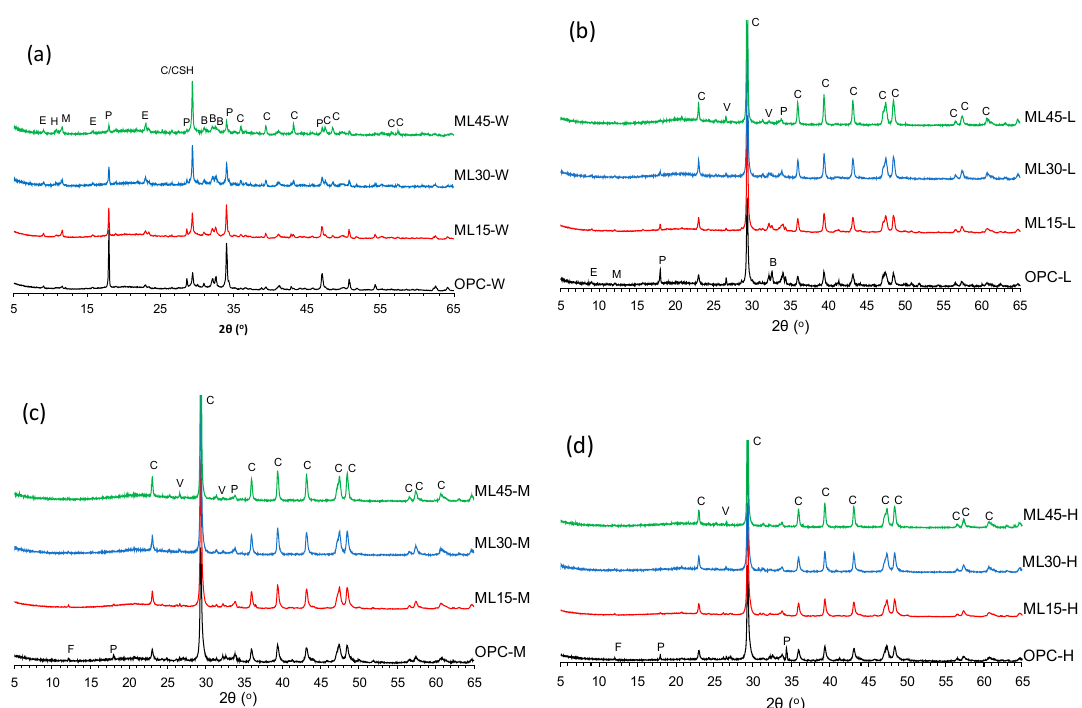
Figure 5. XRD patterns of ( a ) W-, ( b ) L-, ( c ) M-, and ( d ) H-series samples. The annotations are as follows: B—belite, C—calcite, CSH—calcium silicate hydrate, E—ettringite, F—brownmillerite, H—hemicarboaluminate, L—larnite, M—monocarboaluminate, P—portlandite, and V—vaterite.